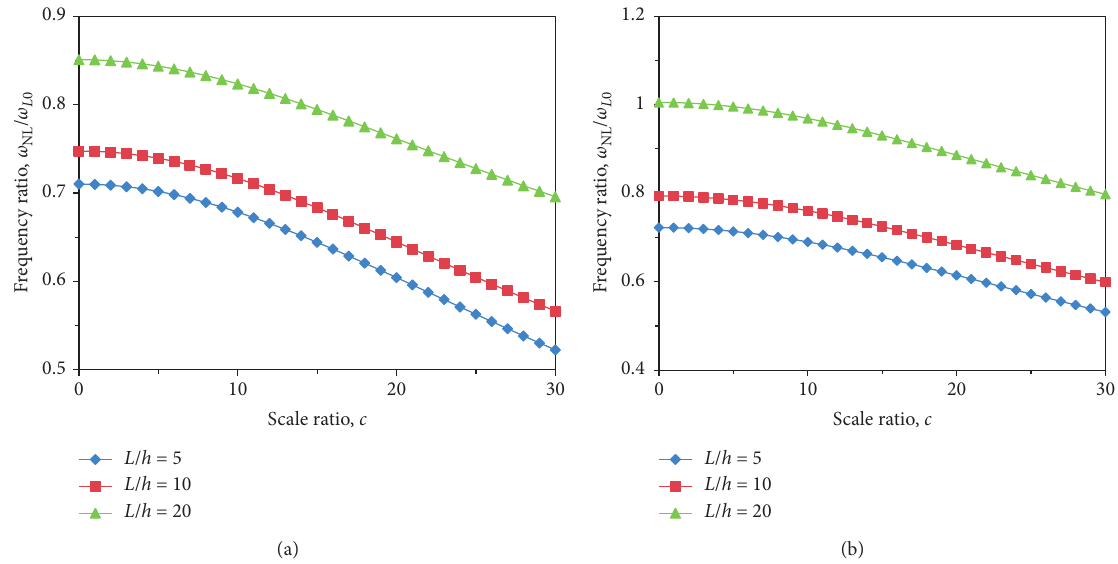
Figure 9: The variation of the frequency ratios of the FG nanobeams to the scale ratio for k � 2, β � 0 . 01, and V thickness effect; (b) with thickness